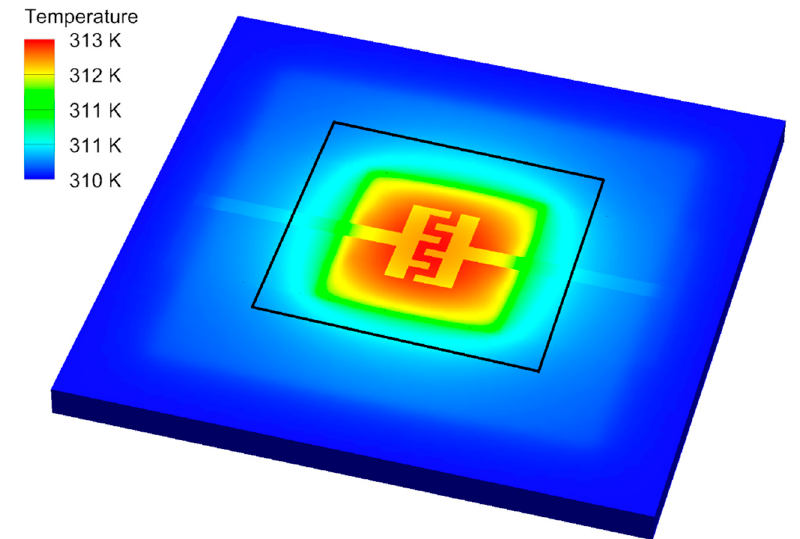
Figure 7. Model of the microheater–culture system with electrodes (with the area of the well marked) and a visible temperature distribution on the substrate in a steady state, after hiding the water layer for the power dissipated from the microheater of 22.64 mW.